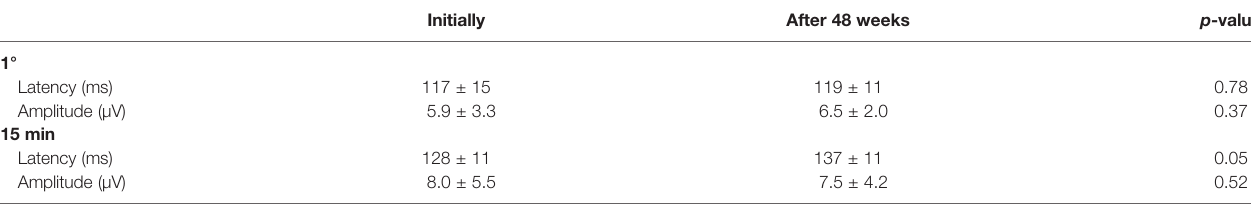
TABLE 3 | Visual evoked potentials.